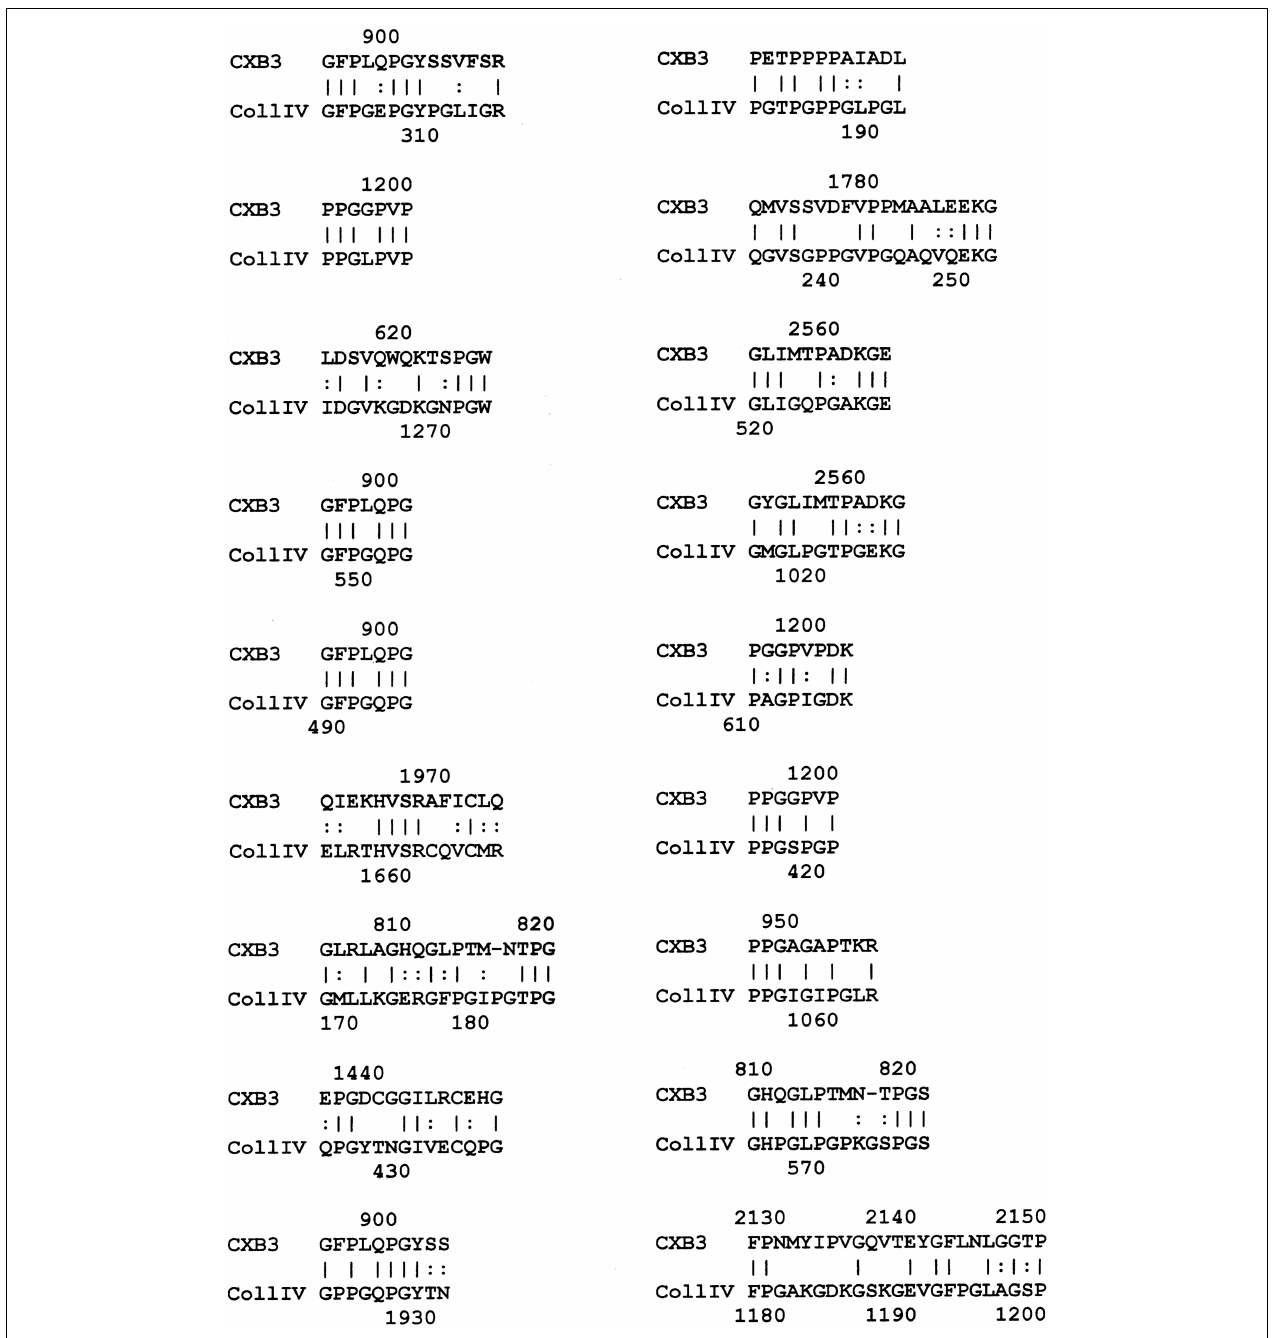
FIGURE 1 | Results of LALIGN similarity search comparing coxsackie B3 virus (P03313) to human collagen IV (P02462) .